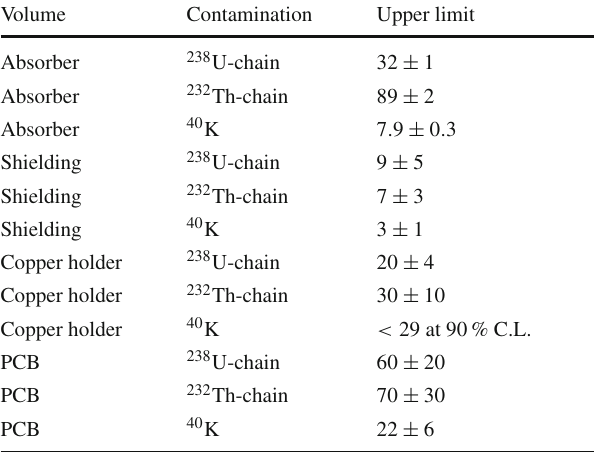
Table 6 Necessary activity concentrations in Bqkg − 1 for a count rate due to radionuclides equal to the unresolved pile-up count rate in the ROI